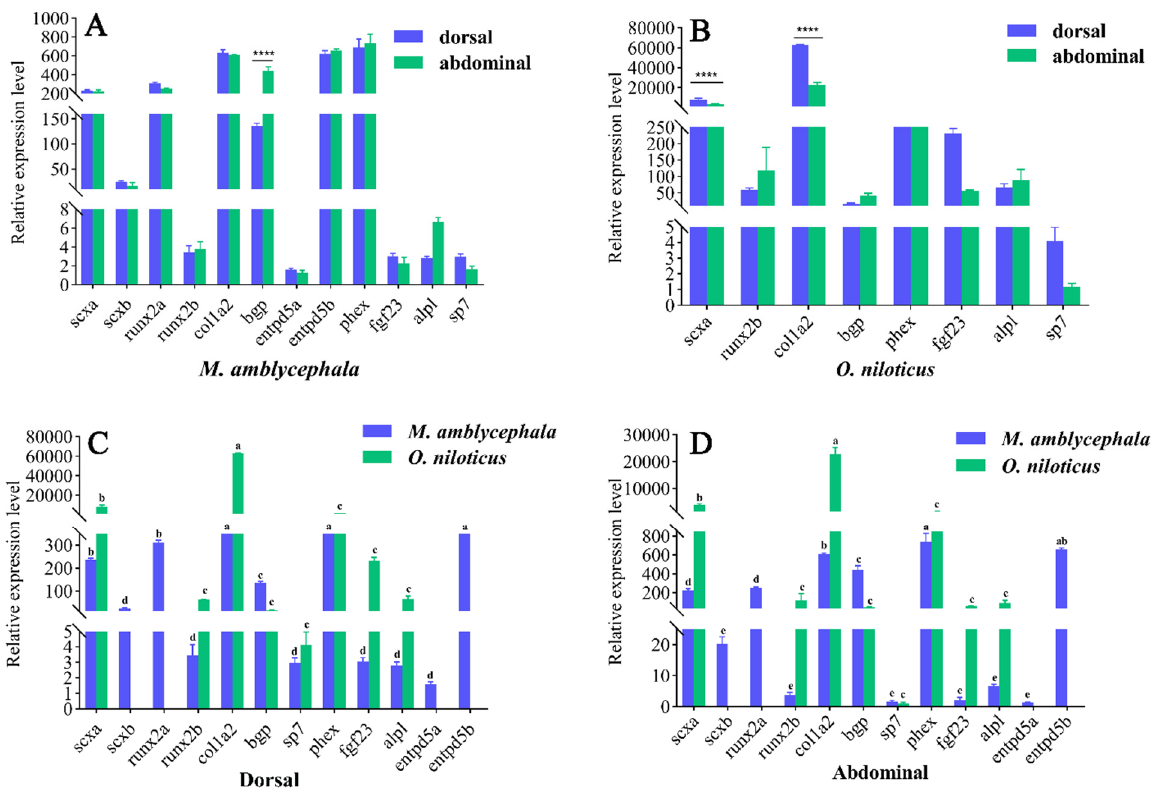
Figure 6. Relative expression levels of the tested genes ( runx2 , scx , entpd5, bgp , sp7 , col1a2 , fgf23 , alpl , phex ) in the dorsal and abdominal parts in one-year-old M. amblycephala and O. niloticus . **** indicates an extremely significant difference ( p < 0.0001); the same letters above the columns for each gene mean no significant difference ( p > 0.05). ( A ) M. amblycephala ; ( B ) O. niloticus ; ( C ) comparison between M. amblycephala and O. niloticus in the dorsal part; ( D ), comparison between M. amblycephala and O. niloticus in the abdominal part.